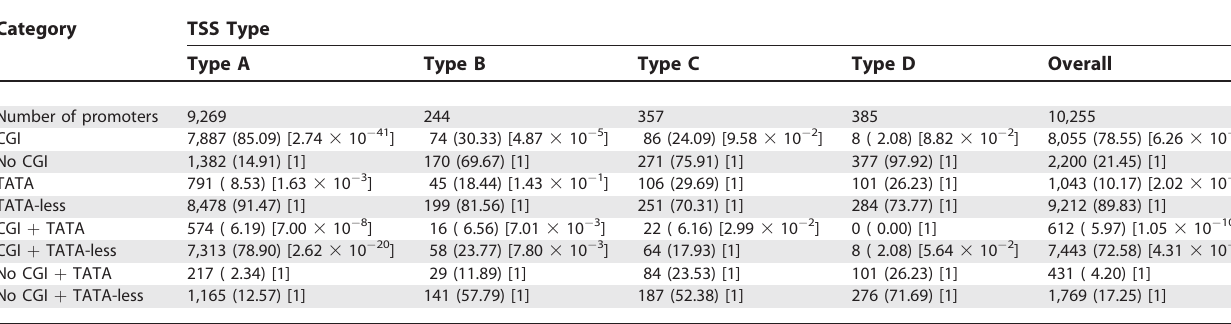
Table 4. Basic Statistics on Relation of TATA Box Motifs, CGIs, and Four TSS Types for HS17 Transcripts